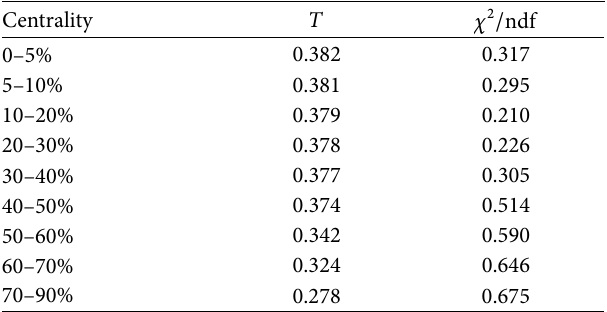
Table 3: Values of parameters used in Figure 1(c). The unit of 𝑇 is GeV.